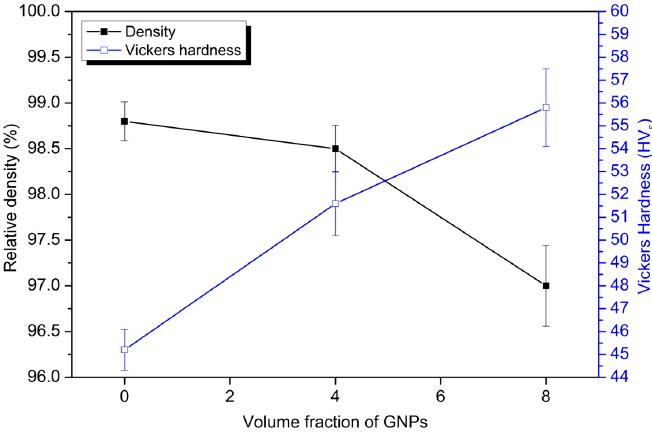
Figure 6. Vickers hardness and relative density of copper composites as a function of GNPs.